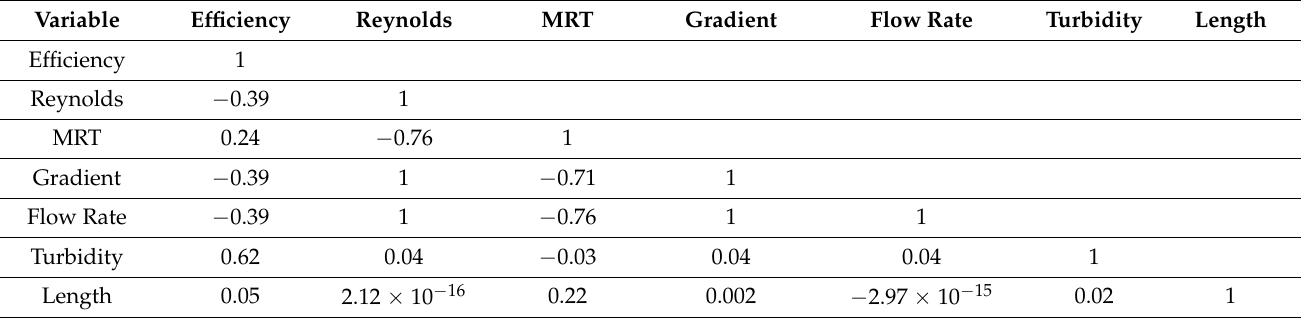
Table 9. Correlation matrix of influential factors in the HTF